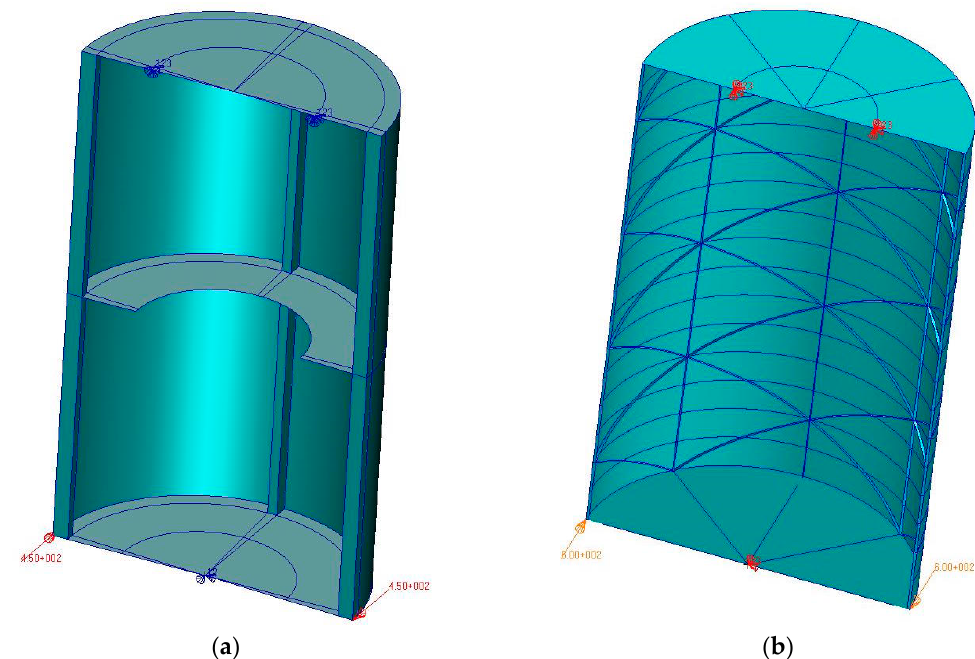
Figure 4. Fragments of geometric models, with visible methods of attachment and loads: ( a ) reference structure, ( b ) structure with isogrid.